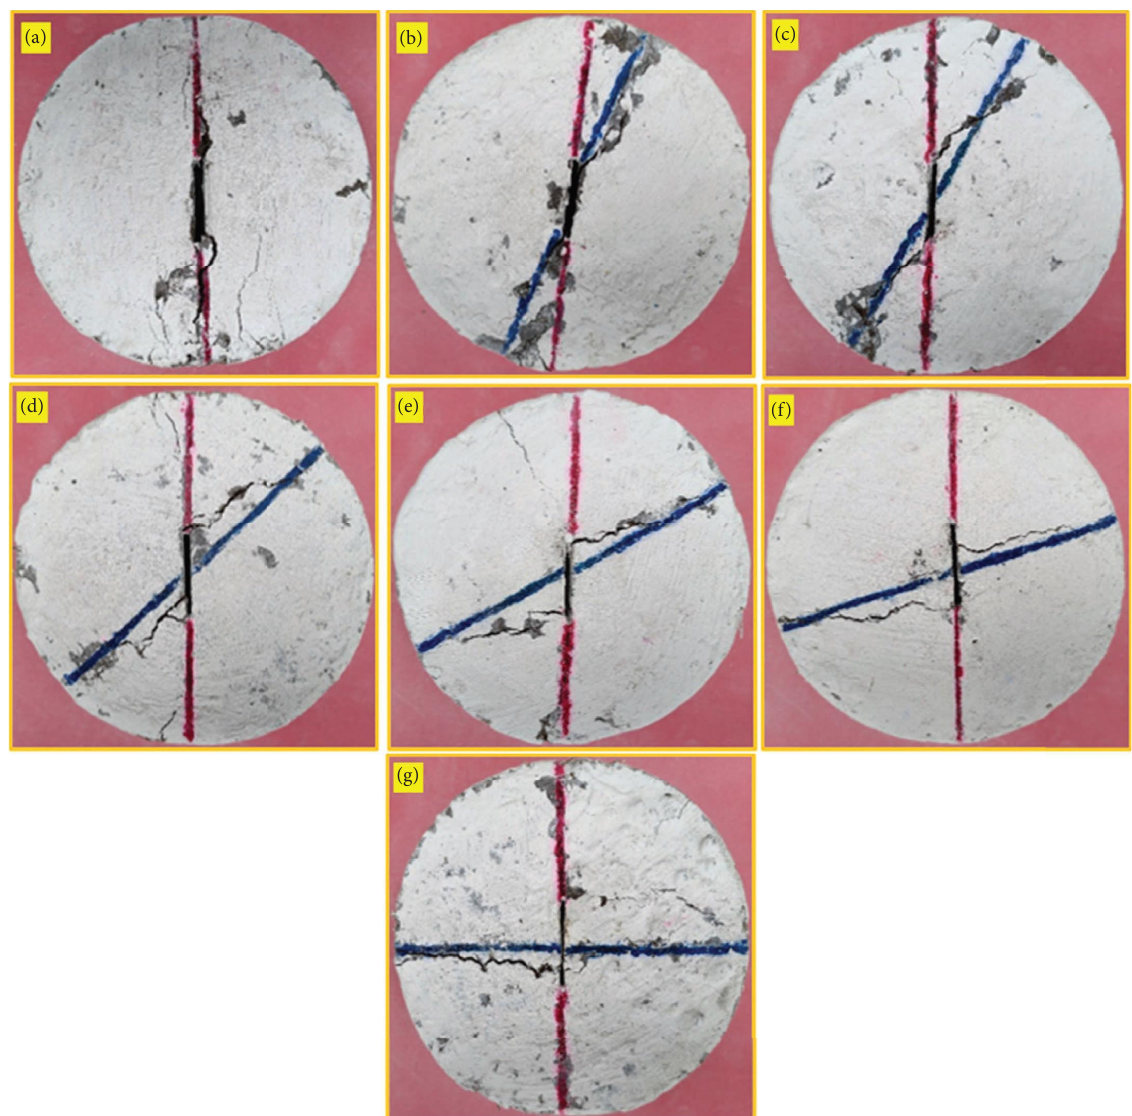
Figure 17: Fracture of short steel fbrous specimens at diferent loading angles: (a) 0 ° , (b) 15 ° , (c) 28.83 ° , (d) 45 ° , (e) 60 ° , (f) 75 ° , and (g) 90 °